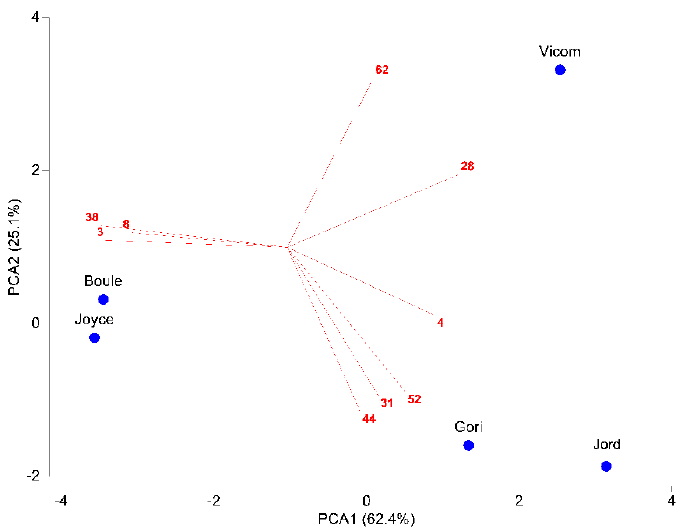
Figure 1. PCA of the matrix 5 taxa × 18 compounds. Compounds with a Pearson correlation coefficient > 0.8 with the first two PCA axes are shown. Abbreviations of chemical compounds: 3 = α -pinene, 4 = camphene, 8 = myrcene, 28 = camphor, 31 = borneol, 38 = verbenone, 44 = bornyl acetate, 52 = α -humulene, 62 = 14-hydroxy-9- epi-(E)- caryophyllene.